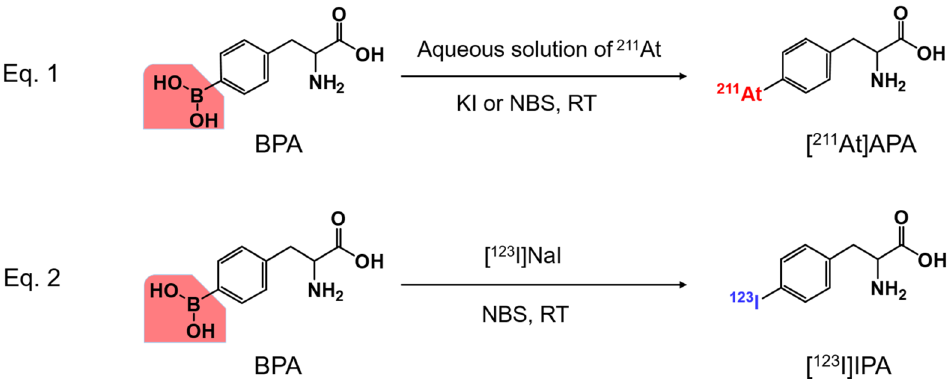
Figure 5. Radio-halogenation of BPA by halogen-dihydroxyboryl substitution